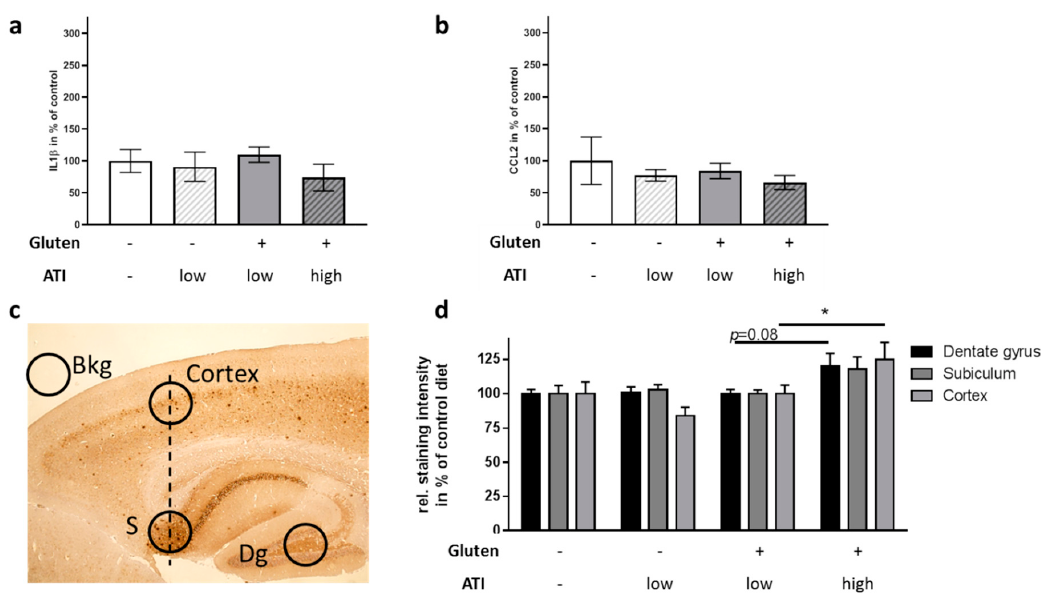
Figure 6. Inflammatory markers and plaque deposition in the brain of 5xFAD mice ingesting different levels of ATIs. ( a ) IL1 β and ( b ) CCL2 mRNA levels were quantified by qPCR and normalized to beta actin mRNA levels. Data present means ± SEM. Statistical analysis was performed by One Way ANOVA ( n = 4–6 animals per group). ( c ) Positioning of densitometric analysis areas on the brain slides (S: Subiculum; Dg: Dentate gyrus). Exemplarily, a slide derived from a mouse fed with gluten- and ATI-free diet is shown. ( d ) Quantitative analysis of A β -containing depositions. Measurements have been corrected for background (Bkg) and are presented as staining relative to area in % of gluten-free / ATI-free diet. Two slides per animal were analyzed ( n = 5–8). All data are given as mean + SEM. Statistical analysis was performed by One Way ANOVA (*, p < 0.05).